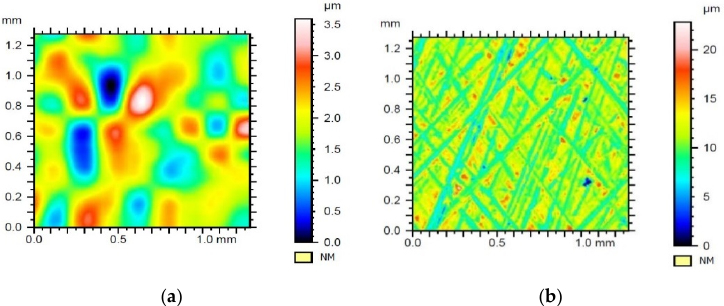
Figure 12. Results of filtration of the surface geometrical structure of sample no. 1 with Daubechies wavelet of the 6th row with the 3rd level of filtration—( a ) waviness, ( b ) roughness.